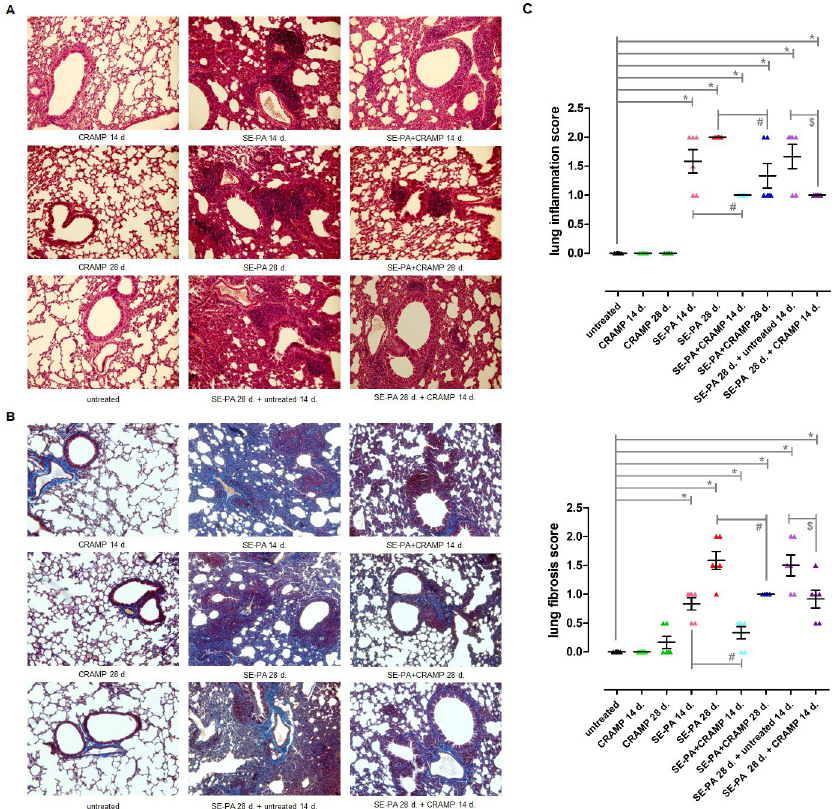
Fig 4. Changes in the morphology of lung tissue of mice exposed to cathelicidin (CRAMP) and/or Saline Extract of Pantoea Agglomerans (SE-PA). Lungs collected from untreated mice and animals exposed to investigated compounds for 14, 28 or 42 days were stained with haematoxylin and eosin (H&E), as well as Masson trichrome dyes (TRI), and examined under light microscopy at magnification 200 × . Each research group contained 8 mice: 6 treated and 2 untreated animals. Samples were collected from all animals and analyzed. (control mice N = 16; treated mice per research group N = 6). A) Representative photographs of mouse lung sections stained with H&E. B) Representative photographs of mouse lung sections stained with TRI. C) Quantification of inflammation and fibrosis in collected mouse lung tissue after H&E and TRI staining. The histological scores were graded with 4 point scales: 0 = regular tissue, 1 = mild changes, 2 = moderate changes, 3 = significant changes. The data for histologic scores for 2 independent investigations are given as mean ± SEM of investigated items. � p < 0.05 vs. untreated; # p < 0.05 SE-PA +CRAMP 14 d./28 d. vs. SE-PA 14 d./28 d. (comparison within corresponding time points); $ p < 0.05 SE-PA 28 d. + CRAMP 14 d. vs. SE-PA 28 d. + untreated 14 d.; one-way ANOVA test; Tuckey post-hoc test.